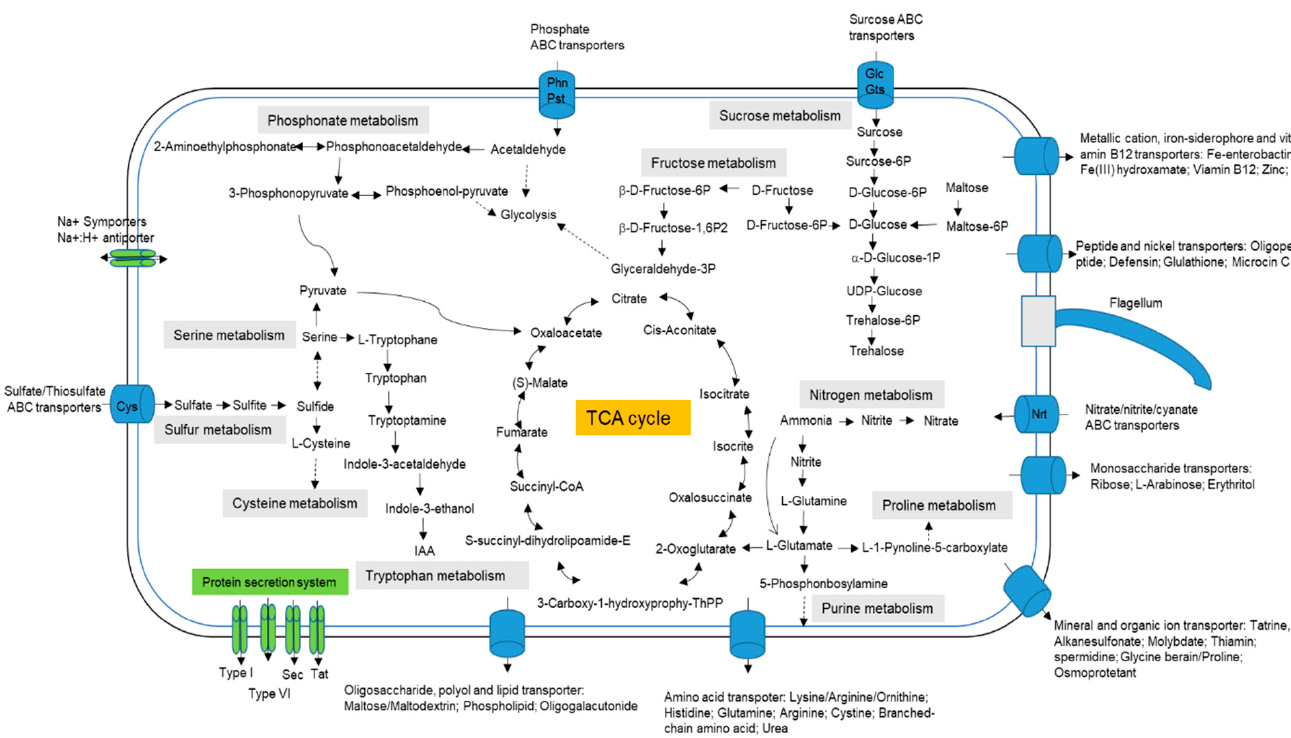
Figure 2. Metabolic pathways of strain KSNA2 T , including the TCA cycle, nitrogen metabolism, phosphate metabolism, sulfur metabolism, and sucrose metabolic pathway. The presence and absence of genes were predicted in Blast KOALA based on the KEGG pathway database.